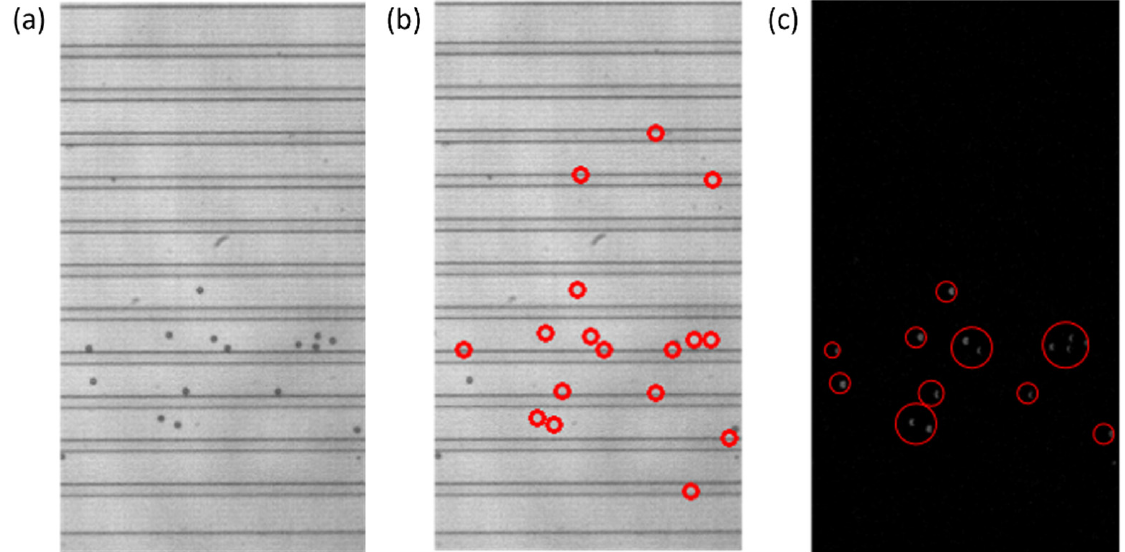
Figure 5. Steps of the particle detection process that include creating a background image for back- ground subtraction and the intermediate steps of consecutive video frame comparison. ( a ) A zeroth frame of a video that contains particles. The image cannot be used as a generic background without modification due to the presence of particles. ( b ) The same zeroth frame of the video with the particles replaced with the average row value. Regions outlined by the red circles represent those particles that were removed from the newly created background image. ( c ) The intermediate step after the comparison or subtraction of consecutive video frames and removal of negative values, before the SimpleBlobDetector function is run. The gray blobs, outlined by the red circles, are particles that will be detected by the SimpleBlobDetector and will be compared to the list of previously detected particles. In order to determine the outlet distribution, the coordinates of the detected particles were compared to the row values of the outlet channel walls. Each of the particles was assigned a channel and the coordinates were placed in a data storage matrix. Then, the percentage of particles in each outlet out of the total was calculated. Figure 4c shows a detailed summary including the coordinates of the center of each particle and the frame number it was detected in, along with the particle